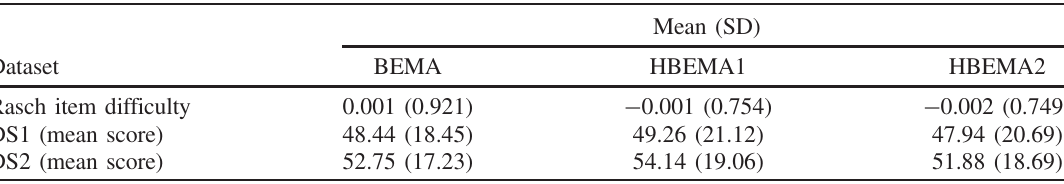
TABLE II. Mean scores comparisons of the two HBEMAs and the full-length BEMA. The first row of data gives the mean values and standard deviations of average item difficulty based on the Rasch analysis outcomes of BEMA [26]. For DS1 and DS2, the mean and standard devotion (SD) of students ’ scores are computed in percentage